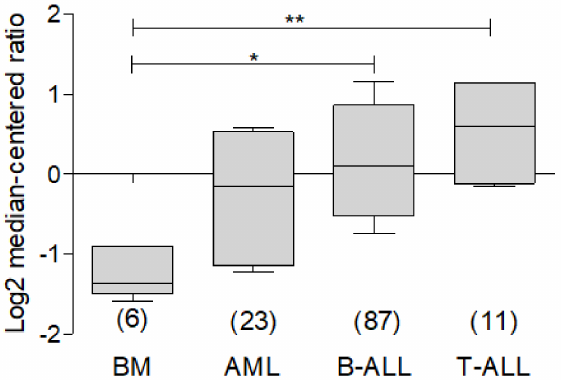
Figure 5. Analysis of BCL-xL expression in different subtypes of leukemia. Bioinformatic analysis with ONCMOINE of BCL-xL expression on leukemia. In the dataset of Anderson et al. [44], analysis of BCL-xL expression shows a significant higher expression in B-ALL and T-ALL compared to bone marrow (* p < 0.05, ** p <